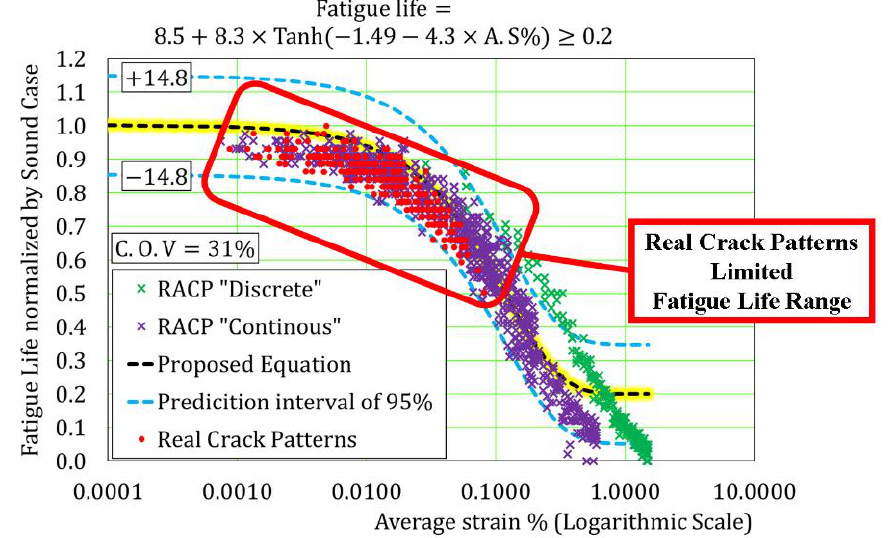
Figure 7. Relationship between the average strain and the fatigue life of real crack patterns and randomized artificial crack pattern program (RACPs).